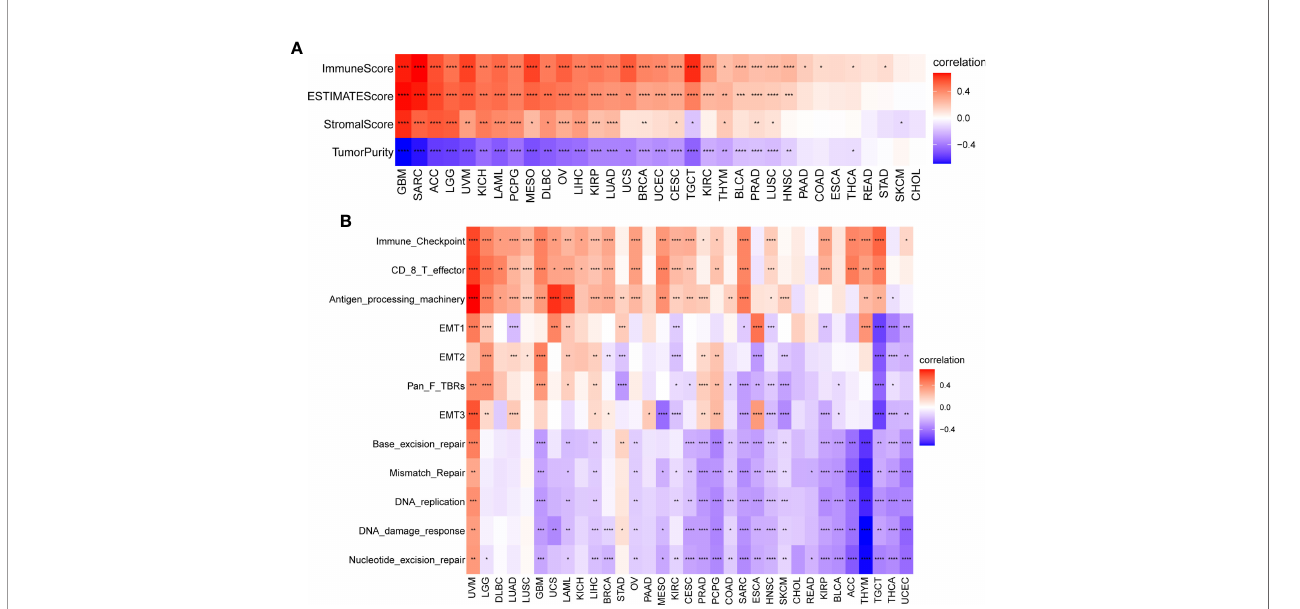
FIGURE 10 | TME analysis of TRP score. (A) Heatmap of the correlation between TRP score and immune score, stromal score, ESTIMATE score, and tumour purity score in pan-cancer. (B) Heatmap of the correlation between TRP score and TME-related pathways. * P < 0.05, ** P < 0.01, *** P < 0.001, **** P <